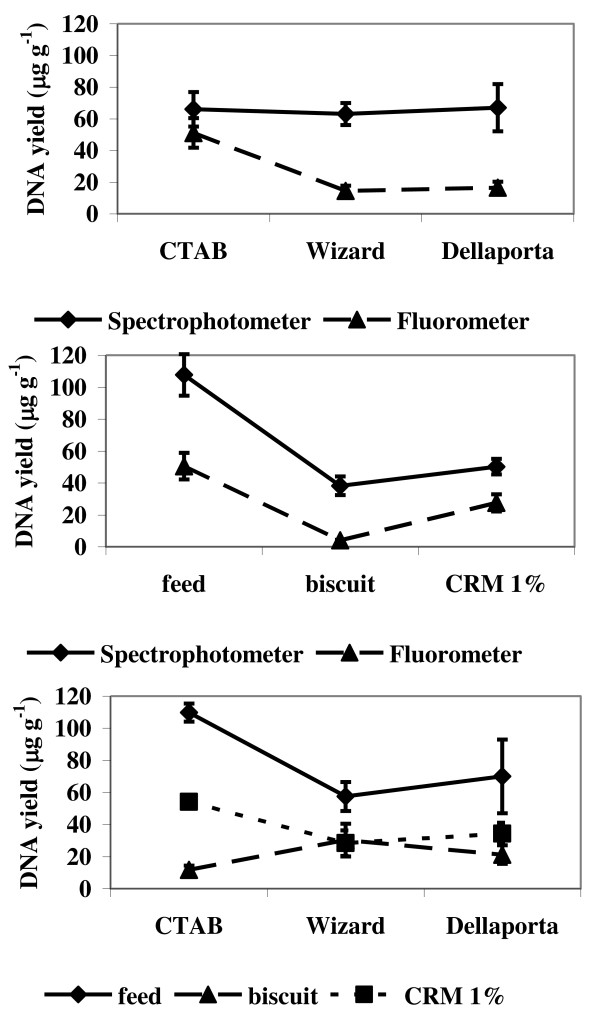
Interaction effects (mean and standard error): DNA extraction method/method for DNA concentration (top), matrix/method for DNA concentration (middle), matrix/DNA extraction method (bottom).